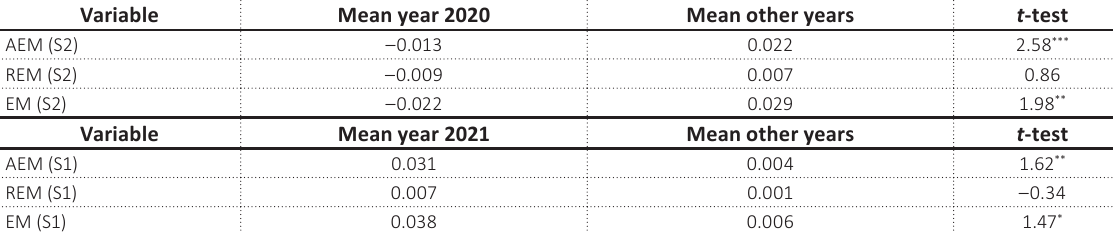
Table 3. Differences between earnings management